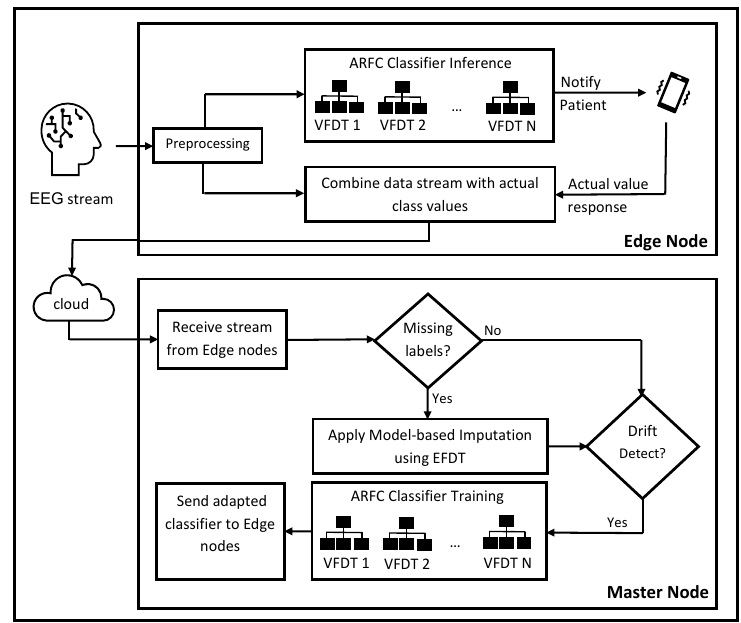
Figure 1. The diagram of ARFC for classifying EEG data stream in the Cloud.